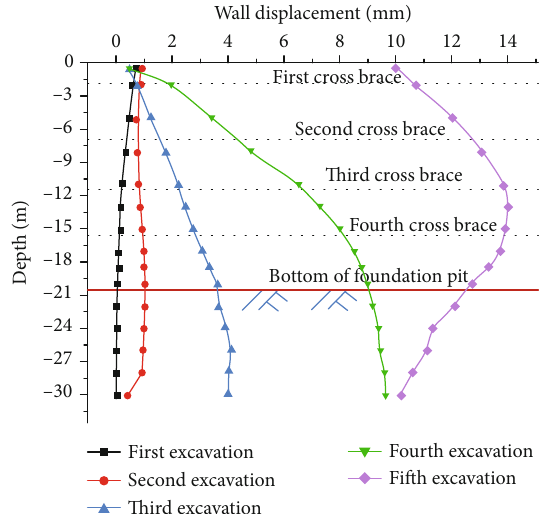
Figure 5: Horizontal displacement of the diaphragm wall in each excavation